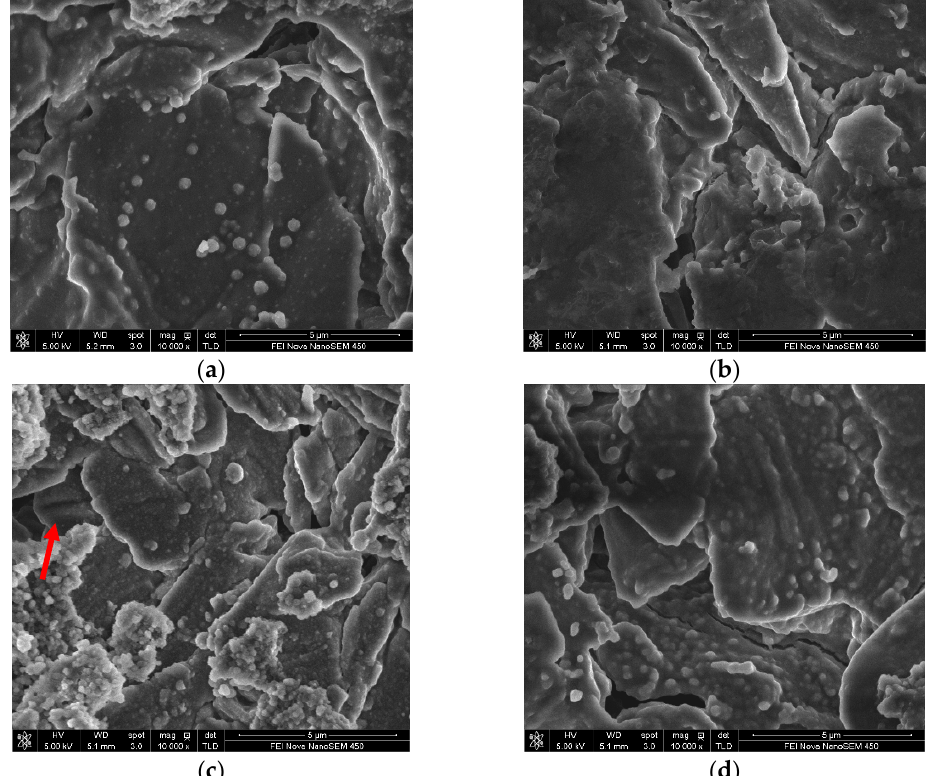
Figure 13. Morphological changes of electrode materials on anodes with different electrolytes before and after cycle tests: ( a ) #5 EL before cycling; ( b ) #8 EL before cycling; ( c ) #5 EL after cycling; ( d ) #8 EL after cycling.